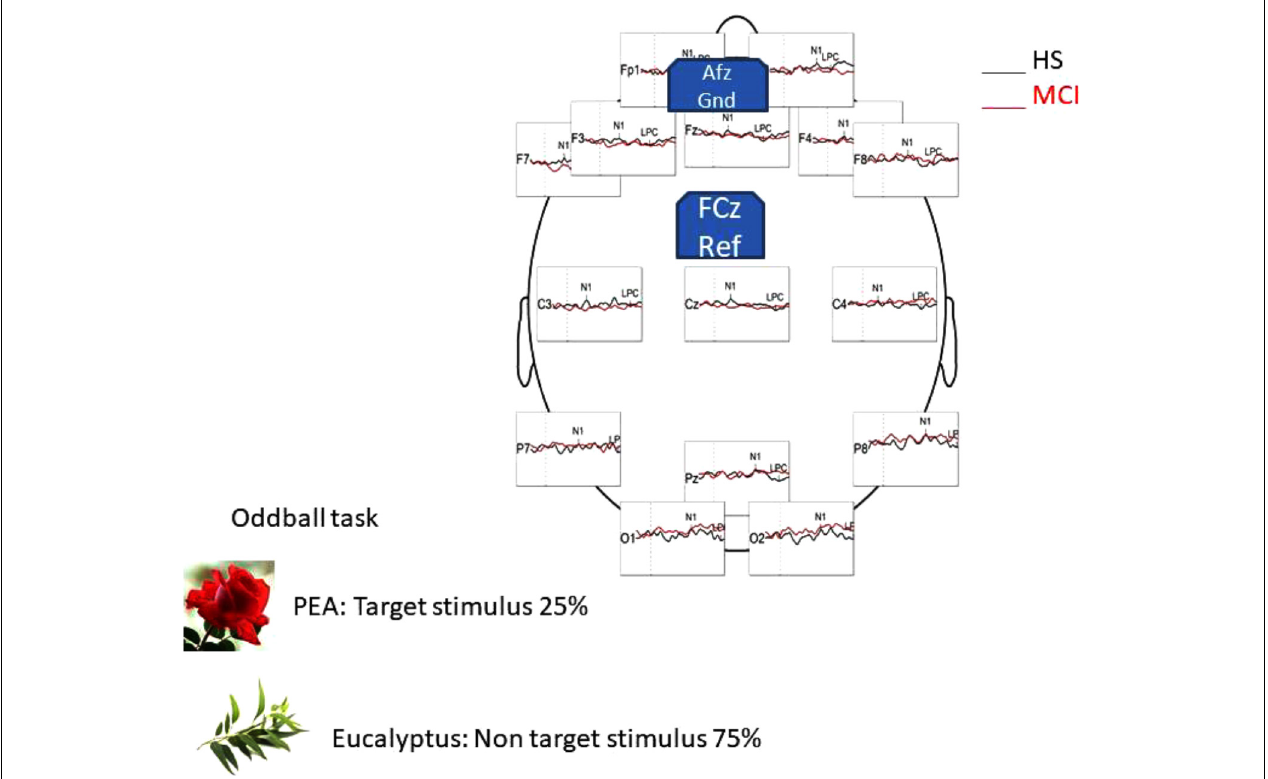
FIGURE 1 | Head representation illustrating the primary EEG montage used for recording during the oddball task in HS group, with a general comparison of OERP component generated by the PEA (rose odorant)